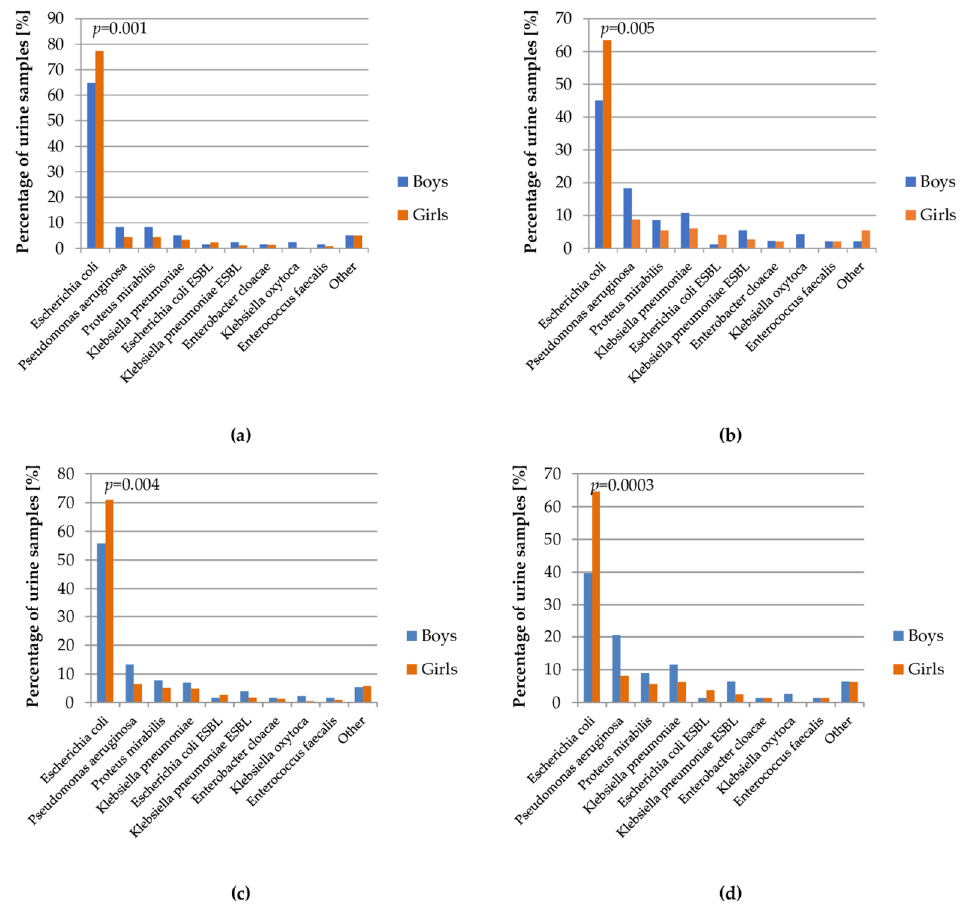
Figure 4. Percentage of bacterial strains in the urine cultures depending on gender of patients: ( a ) total; ( b ) patients with urinary tract defect; ( c ) patients on chemoprophylaxis; ( d ) patients with recurrent UTI.